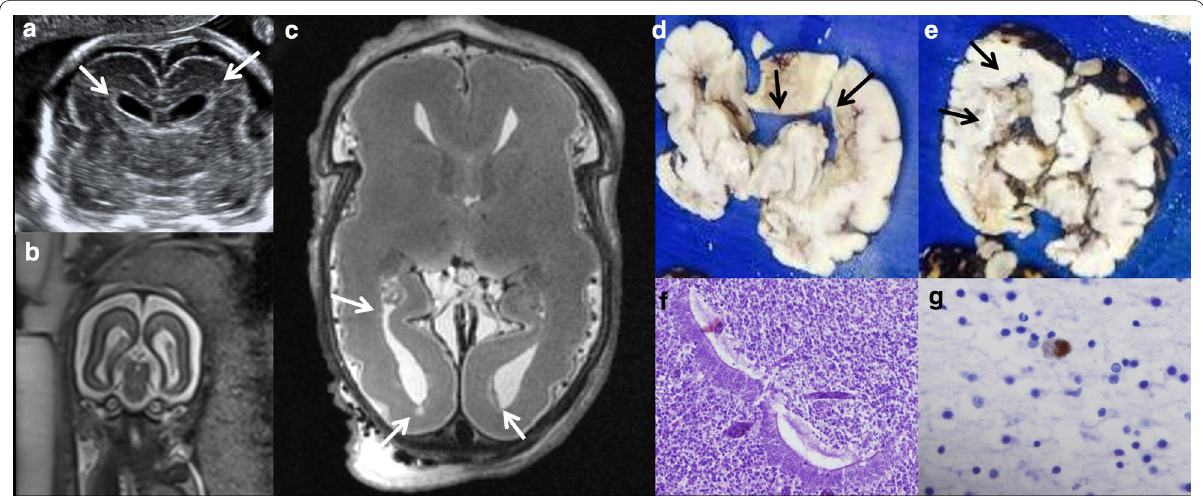
Fig. 9 Cystic periventricular lesions in a 24‑week foetus, elective termination of pregnancy due to CMV infection. a Intrauterine ultrasound demonstrating bilateral periventricular hyperecogenicity (arrows). b Intrauterine MRI showing bilateral ventriculomegaly. c Post‑mortem MRI showing the ventricular dilation and periventricular cysts (arrows). d , e Pathology demonstrating the ventricular dilation (black arrows), macroscopic pathology does not demonstrate the subependymal cysts. f Ventriculitis and periventriculitis with disruption of the ependymal cells (H/E, Positive cell against CMV immunohistochemistry (